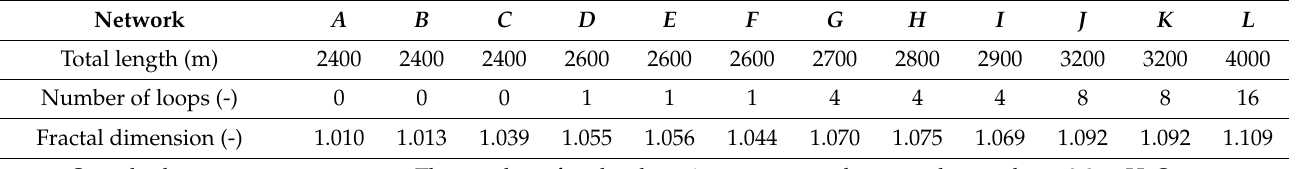
Table 1. Model grid network characteristics (total length, number of loops, and fractal dimension) and numbers of nodes detecting a pressure drop equal to or above 0.8 m H 2 O.